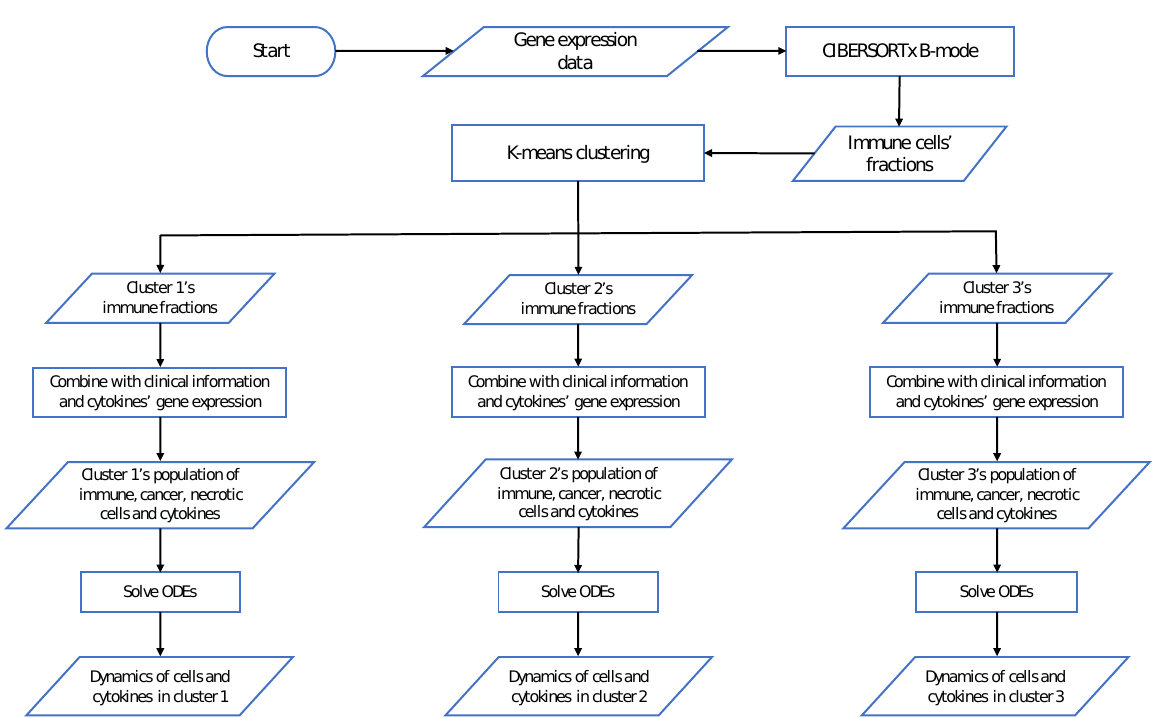
Figure 2. The general workflow of this study. Given the gene expression data of tumors, immune cell fractions were estimated using CIBERSORTx B-mode. Then, K-means clustering was applied to find three clusters with distinct immune compositions. For each cluster, the populations of immune, cancer, and necrotic cells were derived from immune fractions and clinical information. These cell populations and cytokine expression levels were used as input (either as the initial conditions or steady states) in the system of ODEs to find the dynamics of the components of the tumor microenvironment in each cluster.